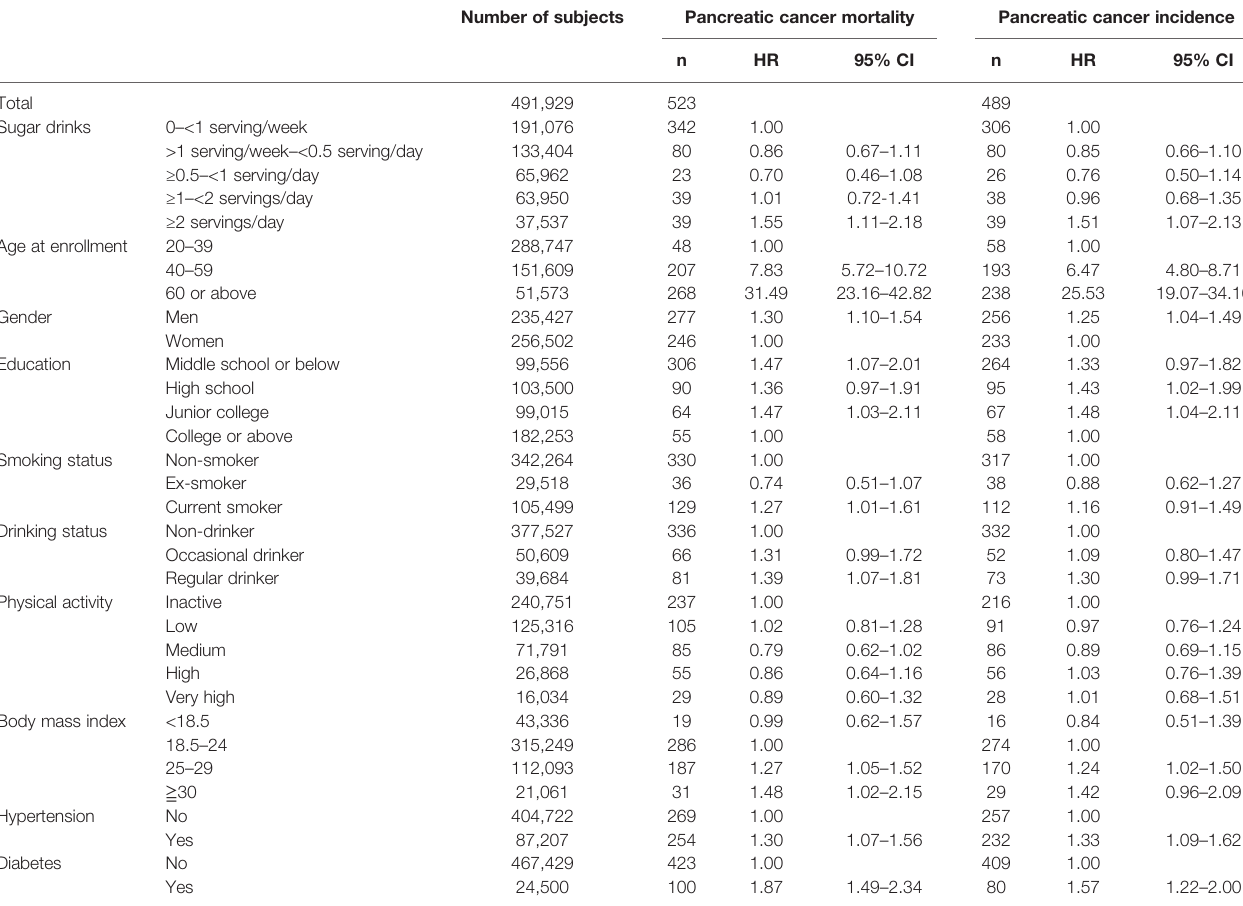
TABLE 2 | Univariate analysis of the possible risk factors for pancreatic cancer mortality and incidence among the total cohort. Number of subjects Pancreatic cancer mortality Pancreatic cancer